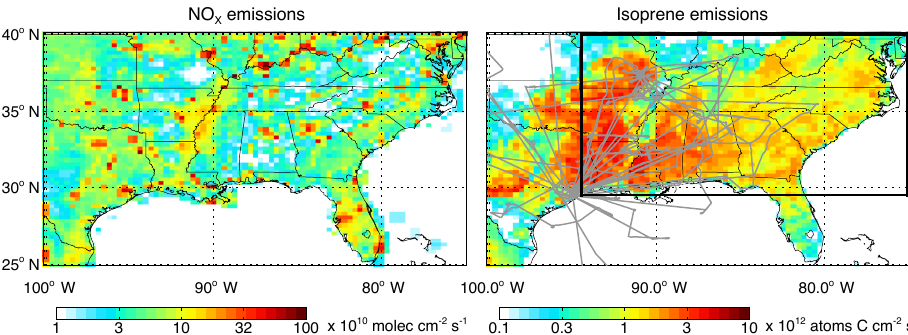
Figure 1. GEOS-Chem surface emissions of NO x and isoprene in August 2013 at 0.25 ◦ × 0.3125 ◦ resolution. See text for emission inventory references. NO x emissions shown here include contributions from combustion and soils but not lightning. Gray lines on isoprene panel indicate flight tracks of the DC-8 during the SEAC 4 RS campaign. The black line delineates the Southeast US as used for regional budget analyses in the